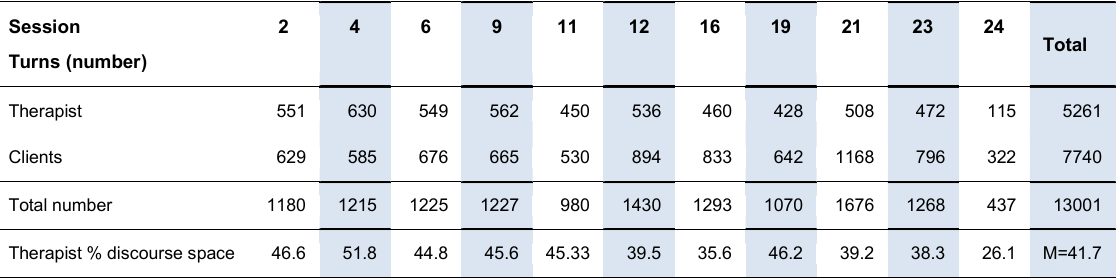
Table 1: Discourse space for the clients and the therapist (the number of conversational turns/interventions) for each therapy session and in total as well as the therapist’s percentage of discourse space Session 2 Turns (number)